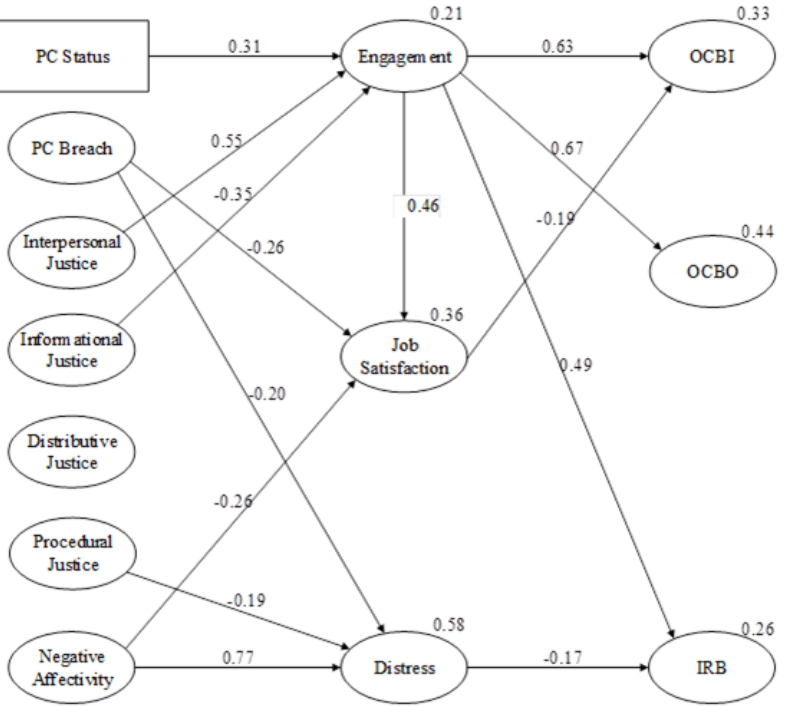
Figure 1. Final structural equation model showing all of the significant